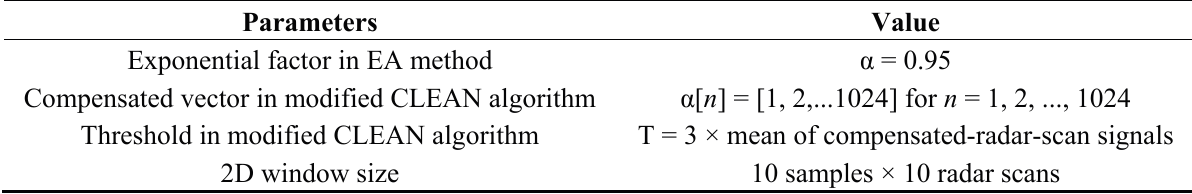
Table 2. Parameters used in the detection signal processing. EA, exponential averaging.